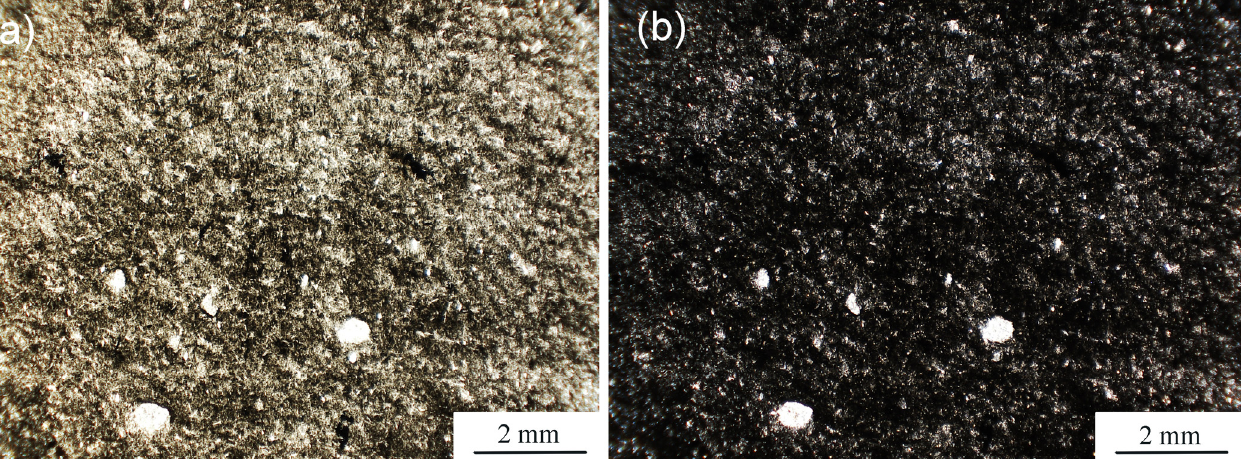
Figure 3. Petrography and mineralogy of the Valongo slate: ( a ) thin section parallel to cleavage (PPL); ( b ) thin section parallel to cleavage (NC); ( c ) thin section perpendicular to slaty cleavage (PPL); ( d ) thin section perpendicular to cleavage (NC); ( e ) semi-quantitative X-ray diffraction data